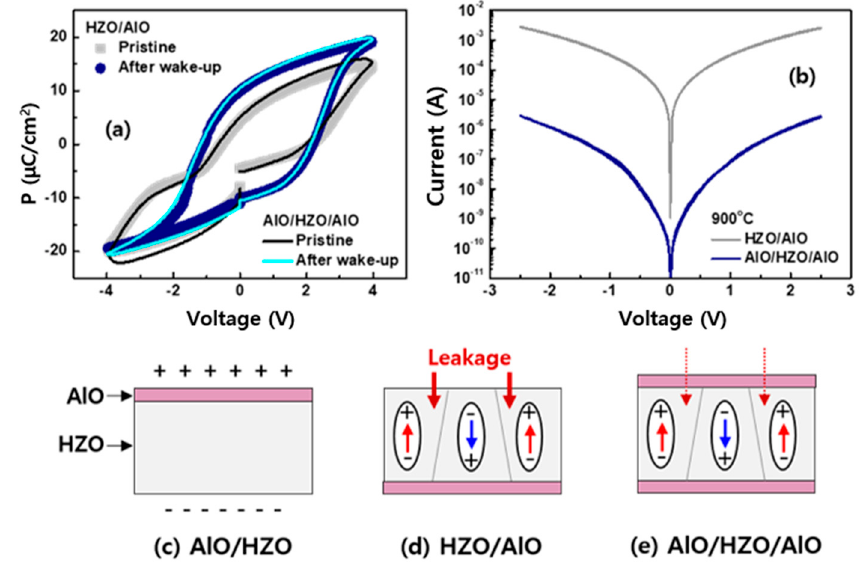
Figure 7. ( a ) The P–V curves of the device systems annealed at 850 °C. ( b ) I–V traces of both device systems annealed at 900 °C. The dielectric and spontaneous polarizations were shown in ( c ) AlO/HZO and ( d ) HZO/AlO structures, respectively. ( e ) Stable ferroelectric switching was observed in the trilayer systems annealed at the higher temperature of 900 °C.